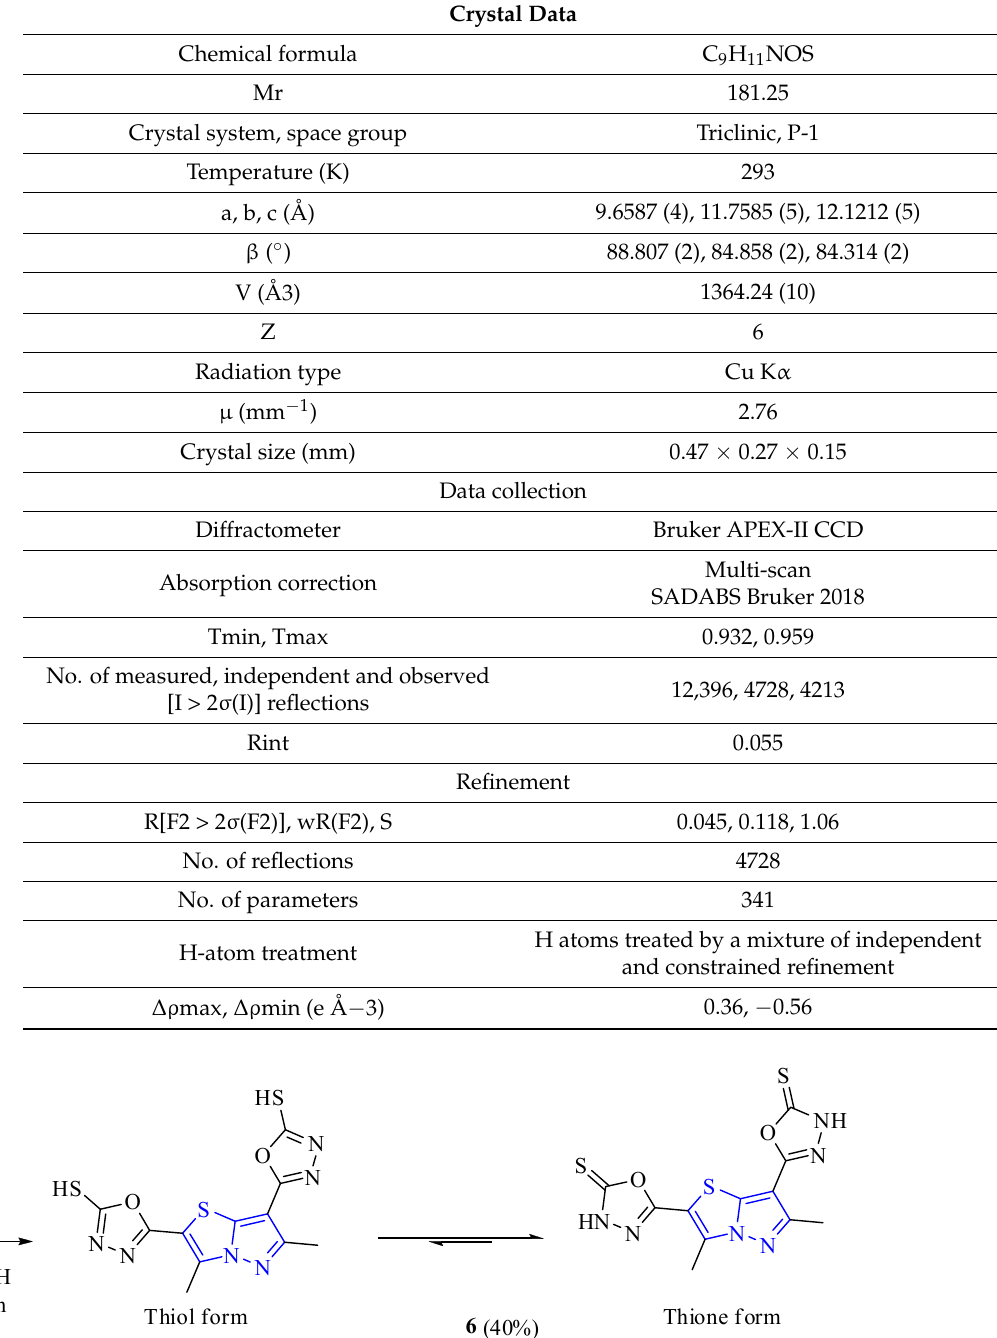
Table 1. Experimental details of compound 4